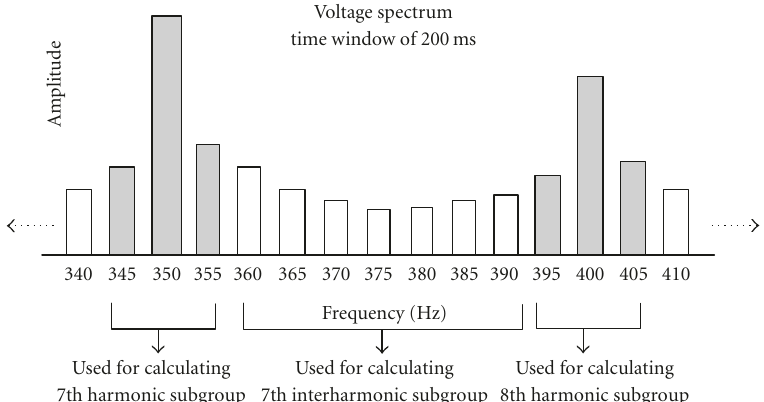
Figure 1: IEC grouping of “bins” for harmonic and interharmonic